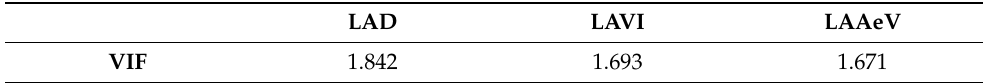
Table 4. Collinearity